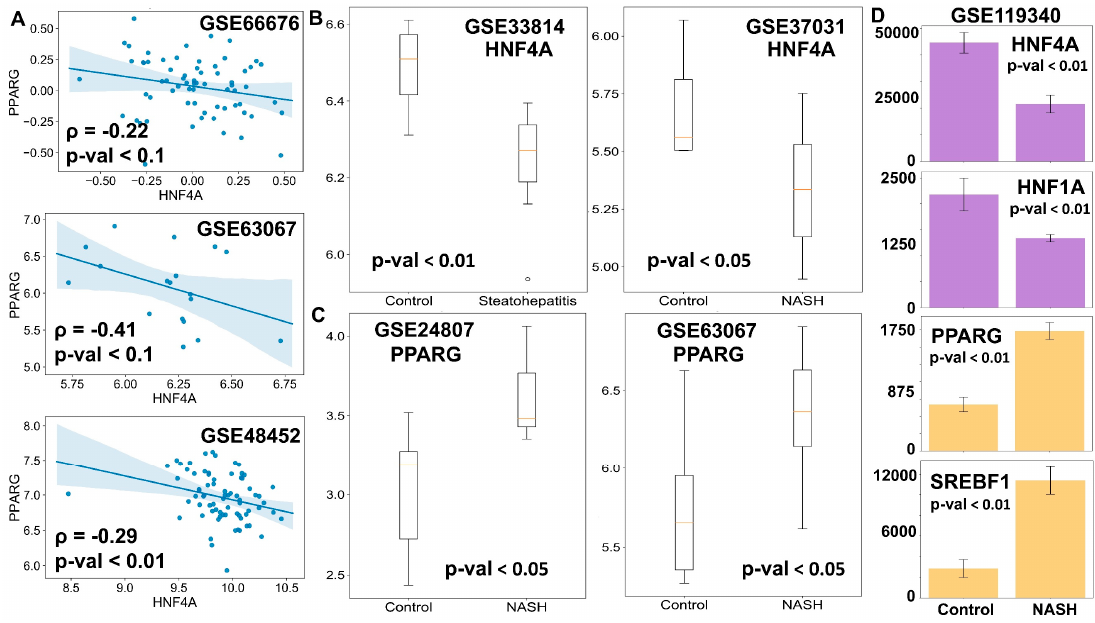
Figure 6. Clinical evidence supports the model predictions. ( A ) Scatter plots between the expression levels of HNF4A and PPARG in clinical samples. Spearman correlation coe ffi cient is given by ρ , and p-val denotes the corresponding p -value. ( B , C ) Comparison of mRNA levels (log2 normalized) of HNF4A ( B ) and PPARG ( C ) in the liver of NASH patients and healthy controls. ( D ) Comparison of levels of HNF4A, HNF1A, PPARG, and SREBF1 in mouse liver for control case vs. mouse model of NASH. Expression values are listed as TPM (transcripts per million) for given RNA-seq data. p -value (p-val) given for Student’s t-test in B-D.